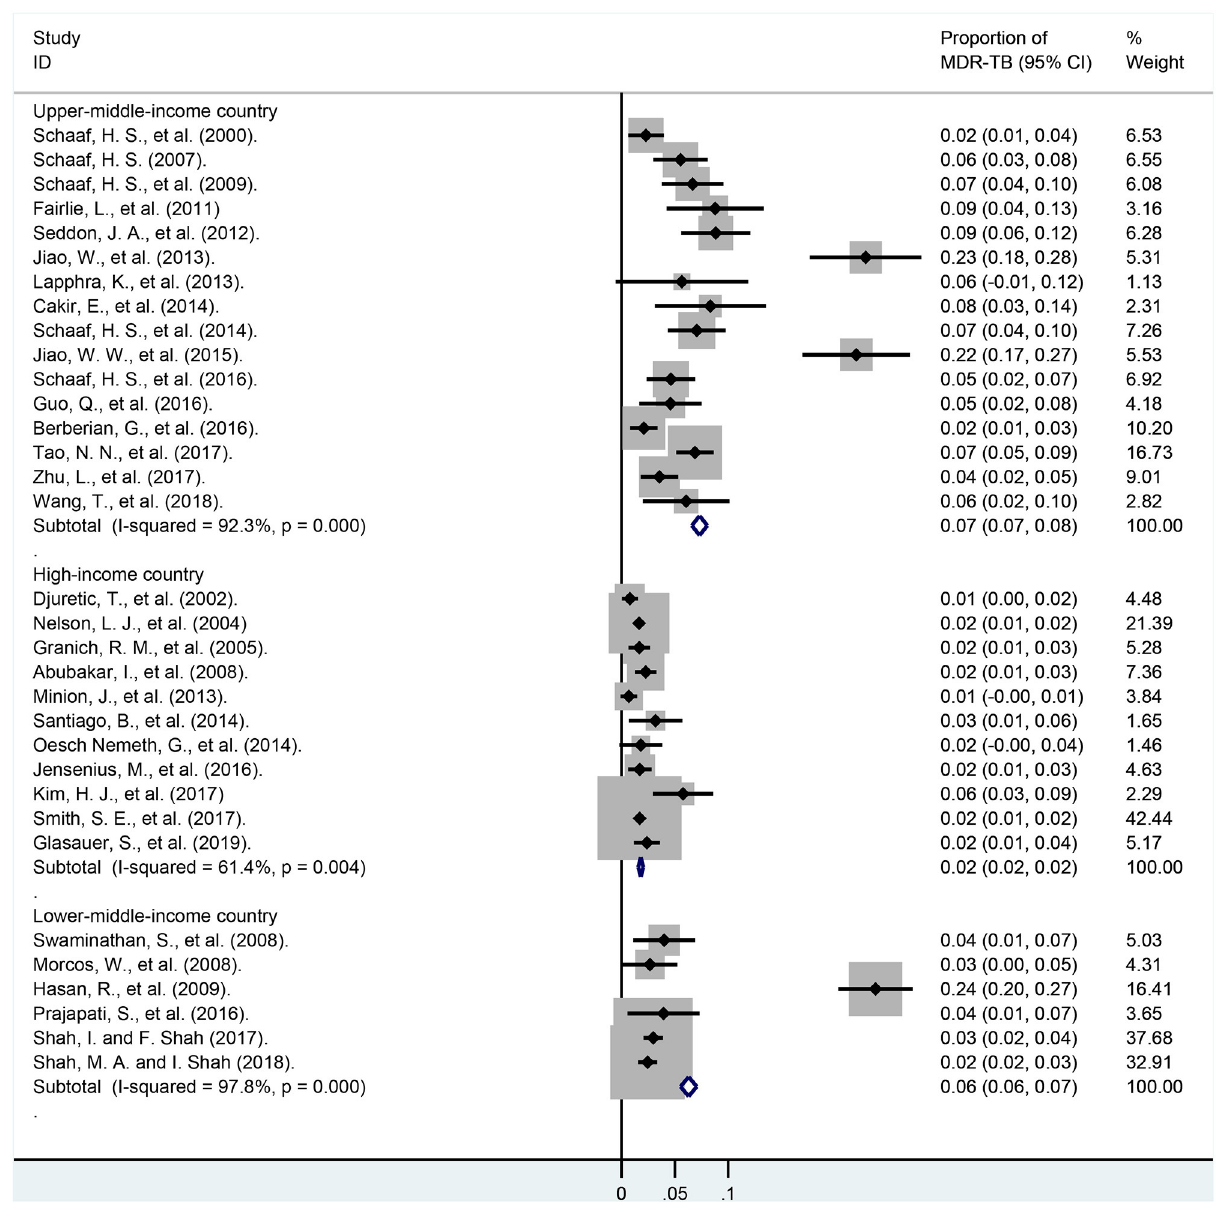
FIGURE 7 | Forest plots for multidrug-resistant tuberculosis ratios in lower-middle-income, upper-middle-income, high-income countries. MDR-TB, multidrug resistant tuberculosis; Horizontal lines represent the 95% CIs around the point estimates for each study and the gray shaded areas are proportional to the weight given to each